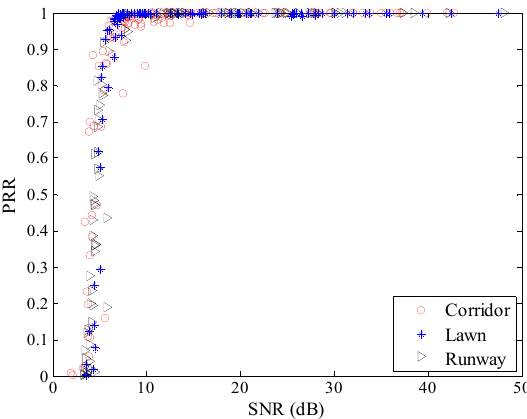
Figure 15. µ snr vs. PRR in di ff erent Figure 15. μ snr vs. PRR in different environments.